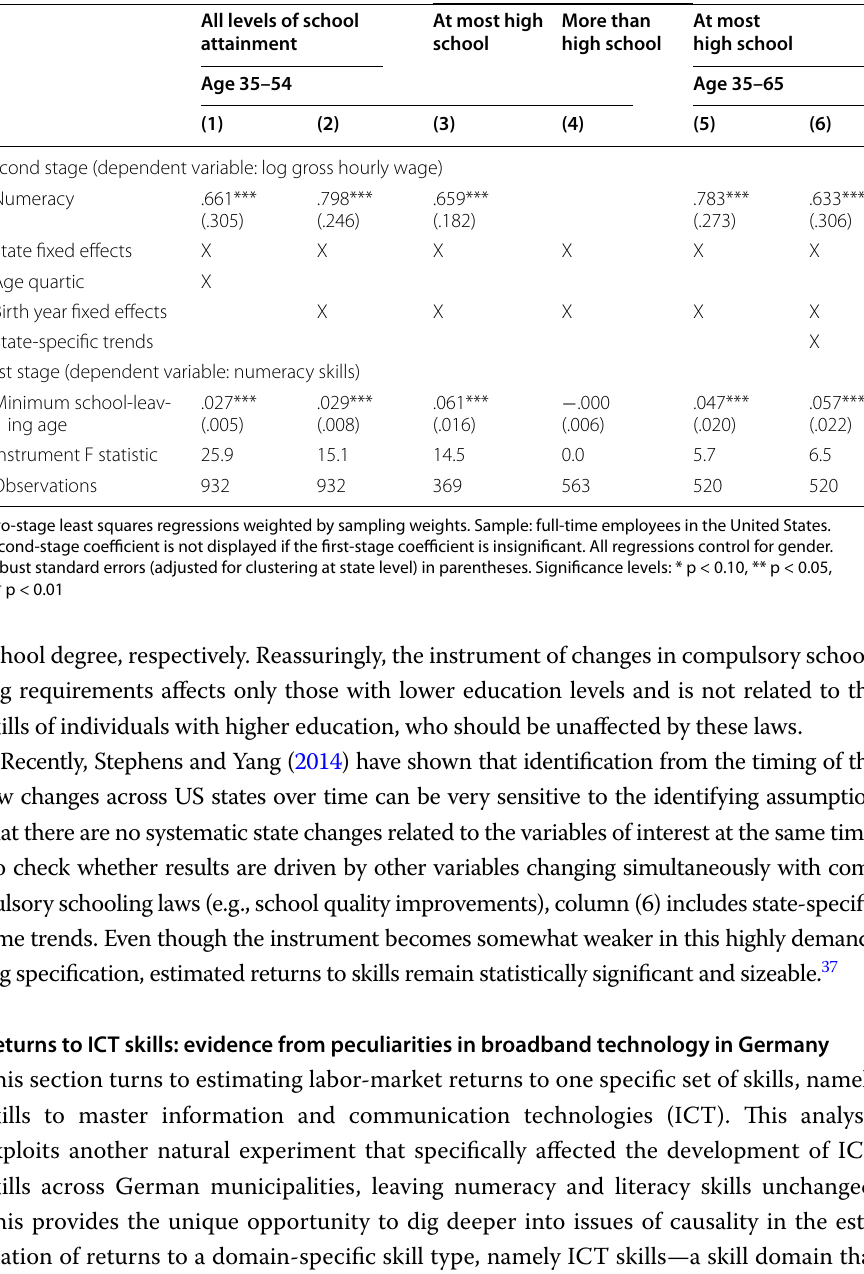
Table 3 Instrumental‑variable models exploiting changes in compulsory schooling laws across US States. Source: adapted from Hanushek and Woessmann (2015)